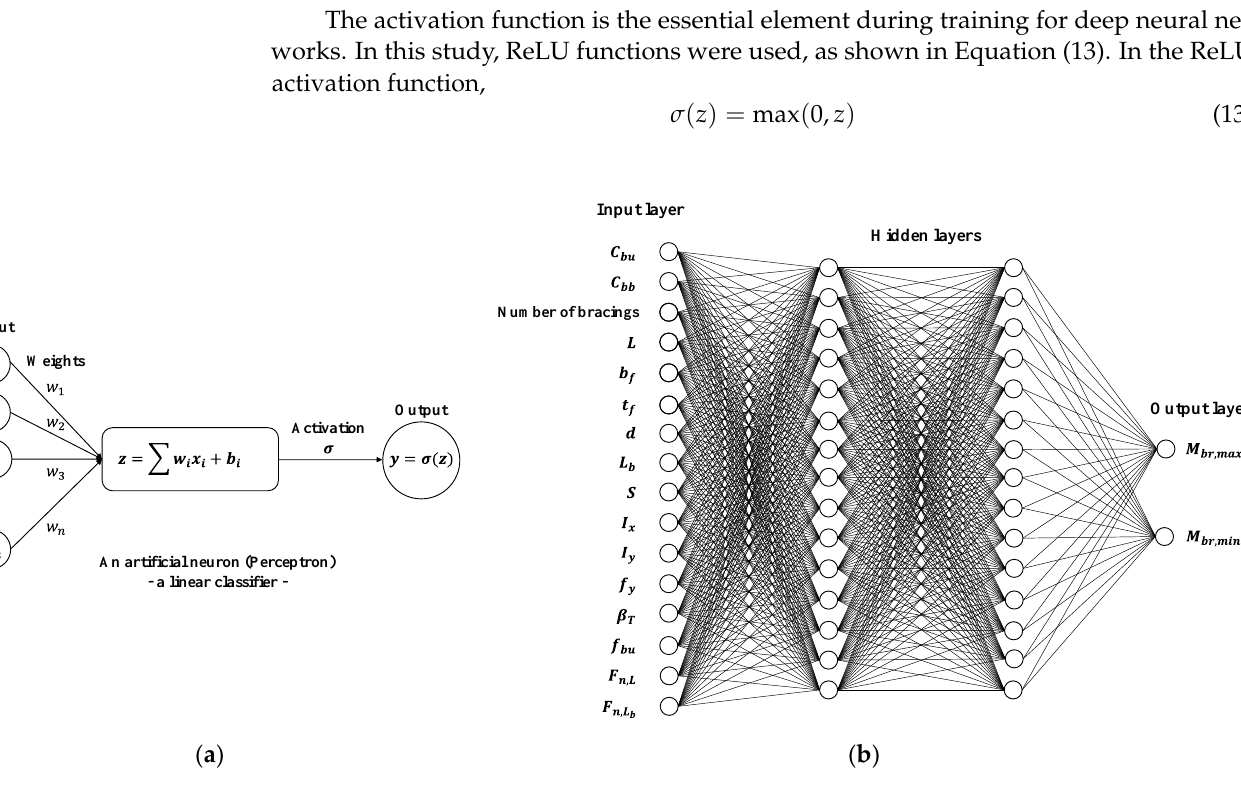
Figure 8. Neural network structures: ( a ) a typical artificial neural network and ( b ) an example of the deep neural network structure used in this study.